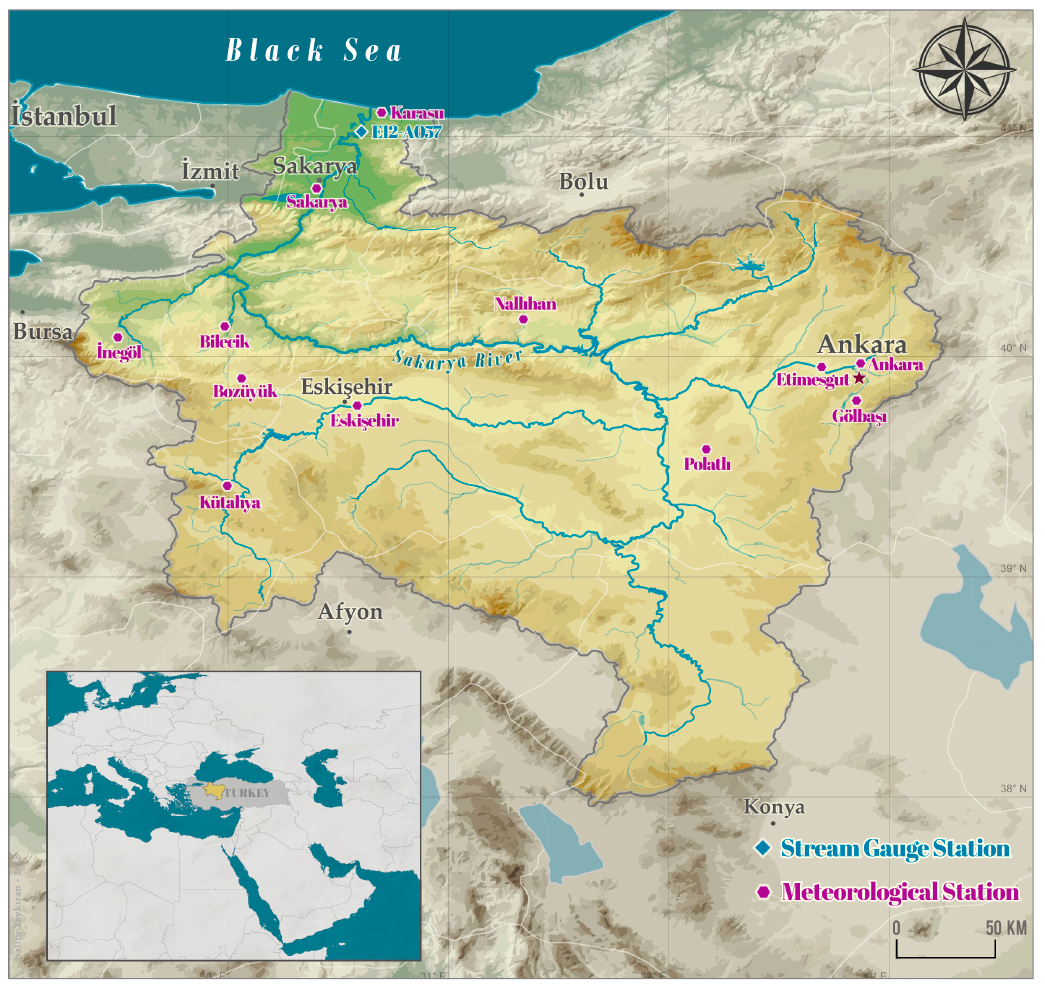
Figure 2. Sakarya River Basin.